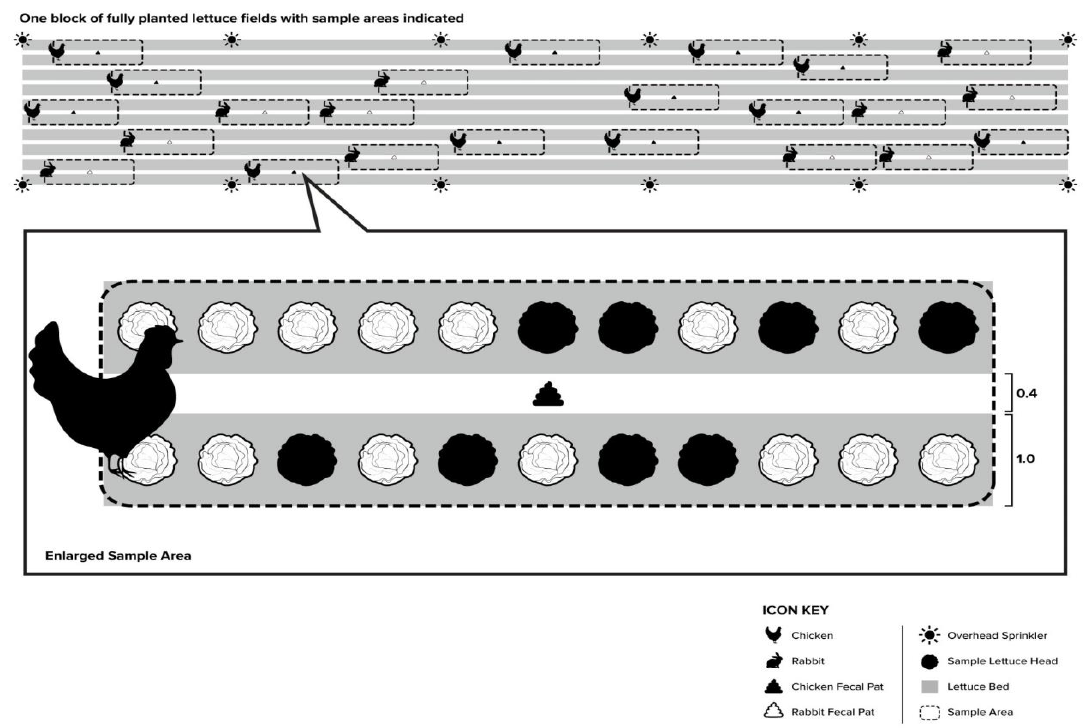
Figure 1. Field layout for one cluster of mature Romaine heads used in the E. coli transfer experiment. Each cluster was composed of eight heads of mature Romaine lettuce equally divided between two adjacent beds on each side of the furrow and a fecal deposit placed in the middle of the furrow.